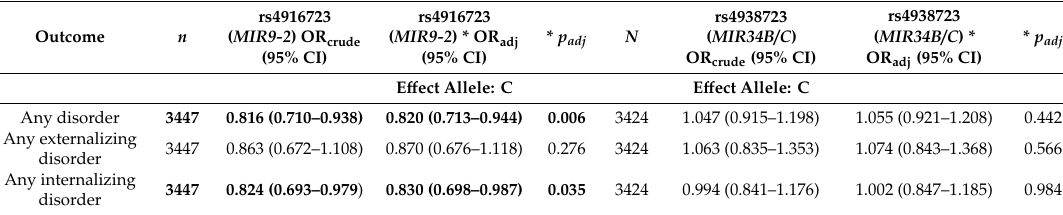
Any internalizing disorder